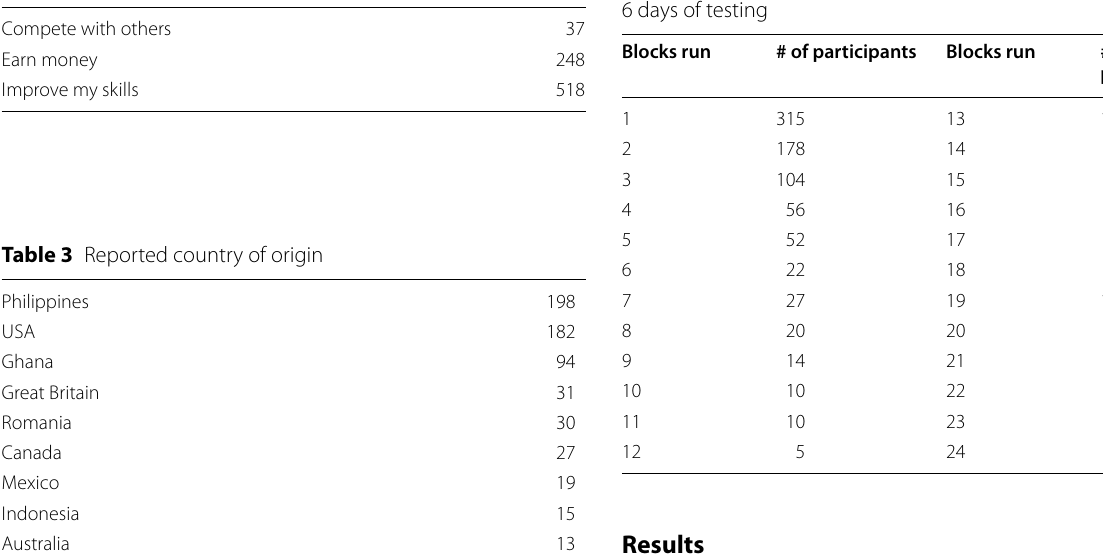
Table 4 Numbers of participants who ran N (1–24) blocks